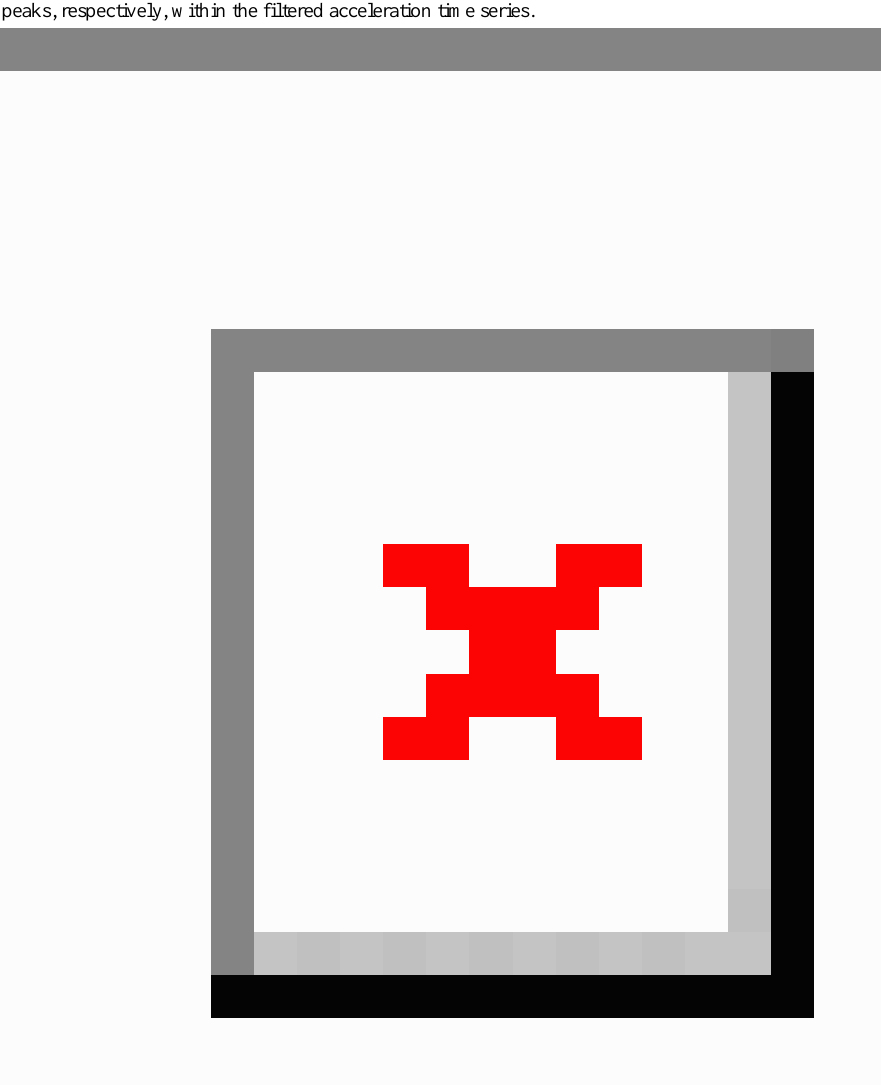
Figure 2. Example of (A) raw and (B) filtered smartphone-recorded accelerations along the earth coordinate system vertical axis during straight walking, relative to identified gait events. Phone-side leg heel-strike and toe-off events derived from a GAITRite mat were overlaid on vertical-axis accelerations acquired by a smartphone placed in the participant’s pocket. These heel-strike and toe-off events correspond to trough nadirs following relatively high peaks and low peaks, respectively, within the filtered acceleration time